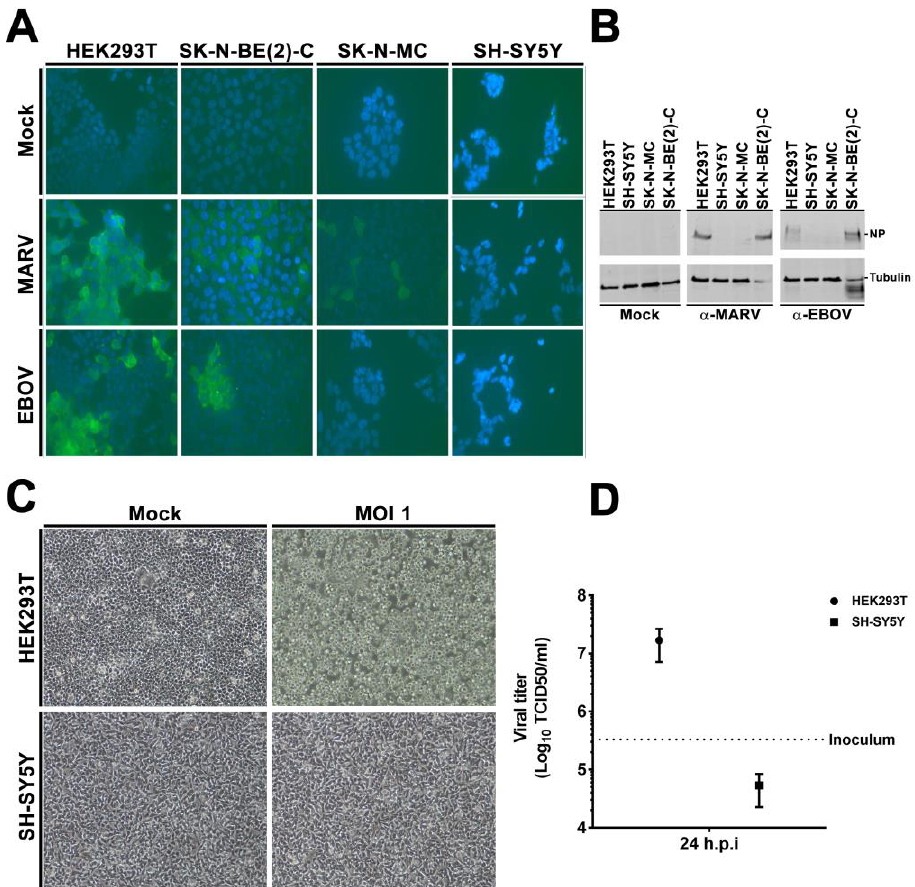
Figure 2. SH-SY5Y is resistant to EBOV and VSV ∆ G-EBOVGP infection. ( A , B ) Authentic filovirus infection. Susceptible HEK293T, SK-N-BE(2)-C as well as resistant SK-N-MC and SH-SY5Y cells were infected with EBOV or MARV or mock-infected for 1 h at a MOI of 0.1. Seventy-two hpi, cells were fixed and stained for EBOV and MARV NP ( A ) using DAPI as counterstaining. Images acquired with a 40 × objective ( B ) In parallel, remaining cells were lysed, and analyzed by immune-blotting for virus NP. α -tubulin was used as internal control. Images and blots are representative of three independent infections. ( C , D ) rVSV ∆ G-EBOV infection. HEK293T and SH-SY5Y cells were infected with rVSV bearing EBOV Mayinga GP for 1 h at 37 ºC. Fresh media was added and cells further incubated for 48 h. A 10 × objective was used for image acquisition ( C ) 48 hpi. GP-specific cell rounding and detachment. ( D ) Cell supernatant was collected 24 hpi and viral titers determined by TCID50.